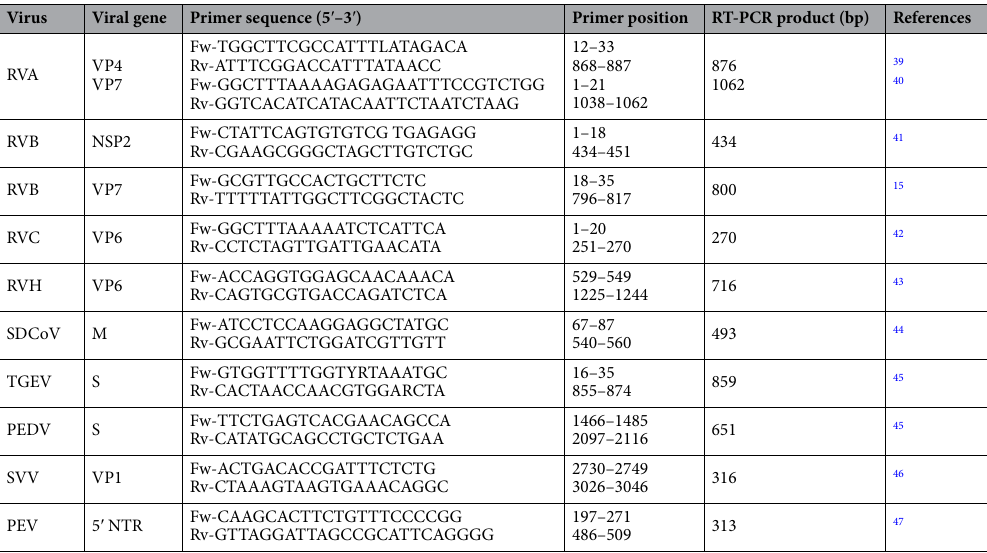
Table 2. Gene targets and respective RT-PCR products used to identify enteric viruses in pig